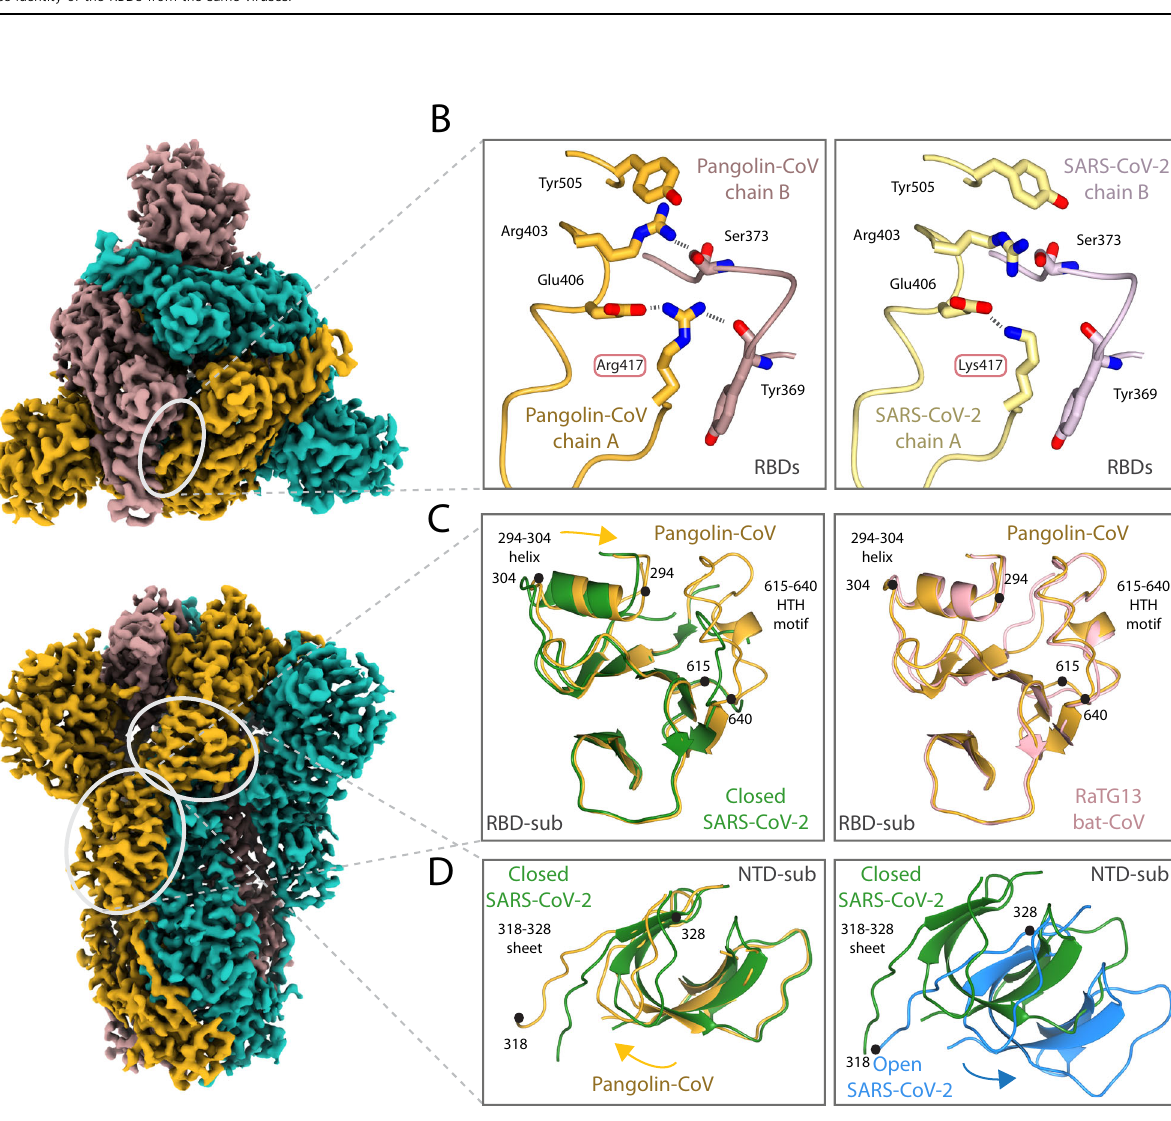
Fig. 2 Structure of Pangolin-CoV spike protein. A EM density representation from the 2.9 Å map of Pangolin-CoV S viewed from down the three-fold axis (top panel) and in the orthogonal view (lower panel). The subunits are coloured in sea blue, golden and rosy brown. The white ovals identify the areas shown in molecular representation on the right. B Comparison of the RBD/RBD interface from the pangolin-CoV (left) and SARS-CoV-2 S (PDB: 6ZGE, right) highlighting the Arg417Lys substitution. C Comparison of the RBD-associated subdomains of the pangolin-CoV (golden) and closed form of SARS- CoV-2 (green) in the left hand panel, showing the different positioning of the 294 – 304 helix and the presence of the 615 – 640 helix-turn-helix in the pangolin structure and, in the right hand panel, the overlap of the same Pangolin-CoV S structure (golden) with the corresponding region from the RaTG13 (PDB: 6ZGF) (pink). D Comparison of (left) the NTD-associated subdomain of Pangolin-CoV (golden) with that of the closed form of SARS-CoV-2 (green) showing the different domain orientations between them; (right) the closed (green) and open (blue) conformations of the NTD-associated subdomain of SARS-CoV-2 showing that the shift in orientation of the NTD-associated subdomain on spike opening is in the opposite direction to the shift seen between the Pangolin-CoV and closed SARS-CoV-2 conformations shown in the left